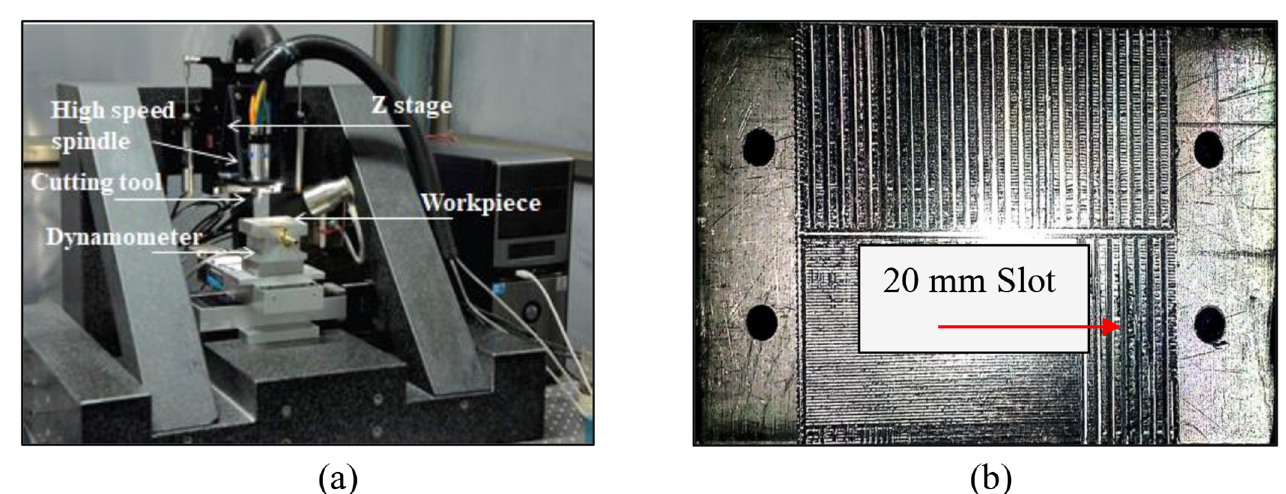
Fig. 9. (a) Micromilling set up and (b) machined Ti-6Al-4V alloy.